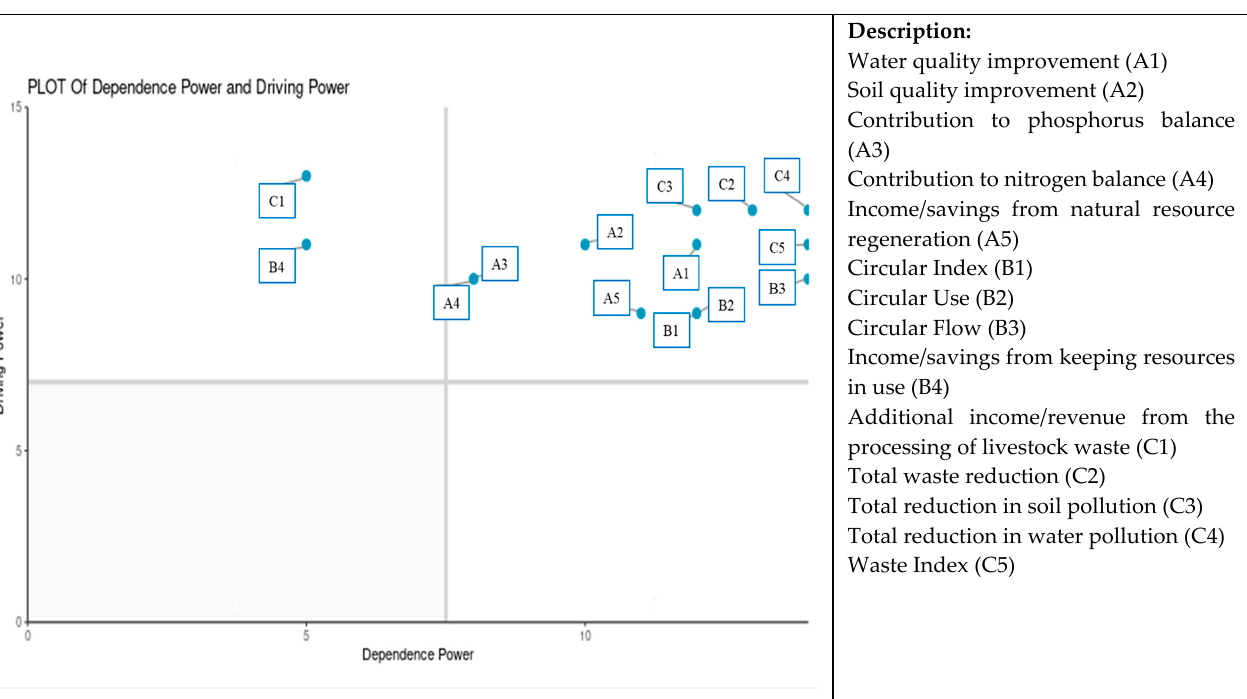
Figure 1. MICMAC quadrant analysis results .